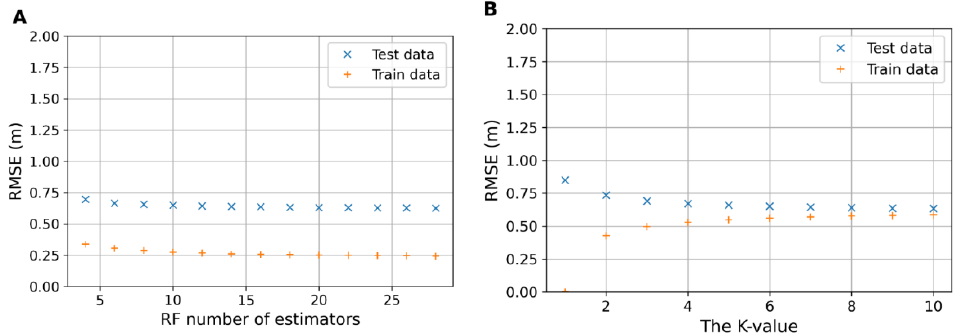
Figure 11. ML hyperparameter tuning: ( A ) number of estimators in RF; ( B ) k-values for KNR.